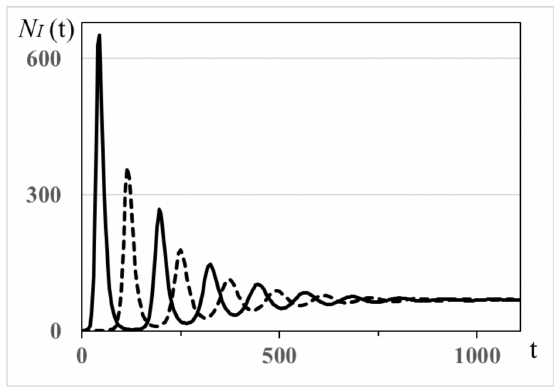
Fig. 3. (cid:4) - values of δ (1) regressions y ( x ) , x = h/a d .